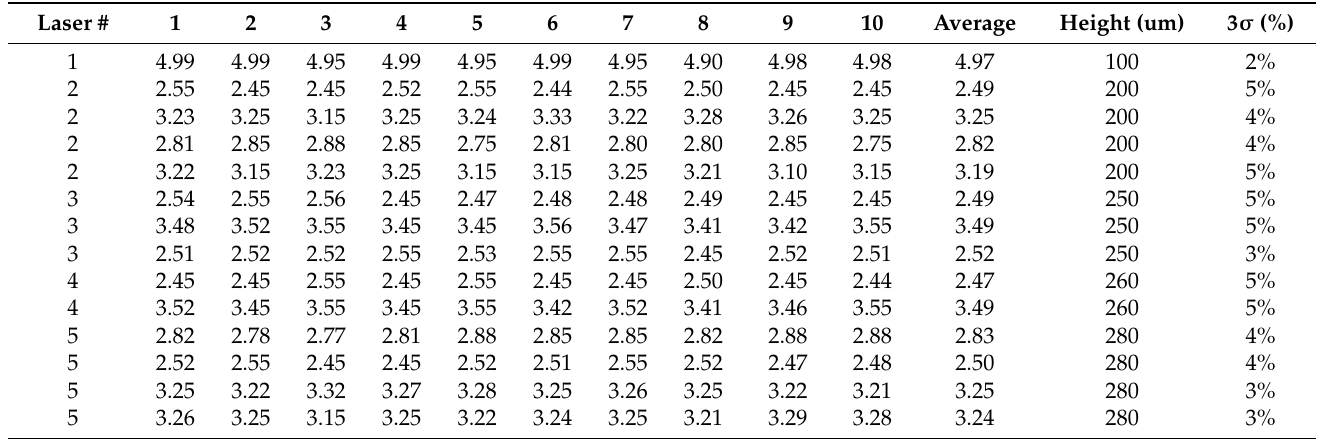
Table 3. Statistics of the uncertainty indicating the ten measurements for three standard deviations (3σ).